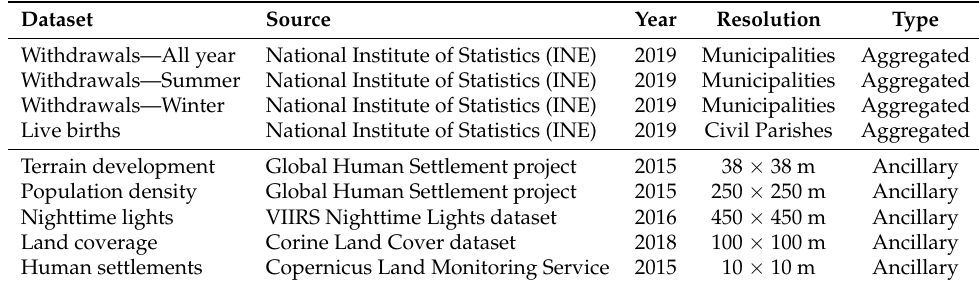
Table 3. The datasets used in our experimental evaluation.